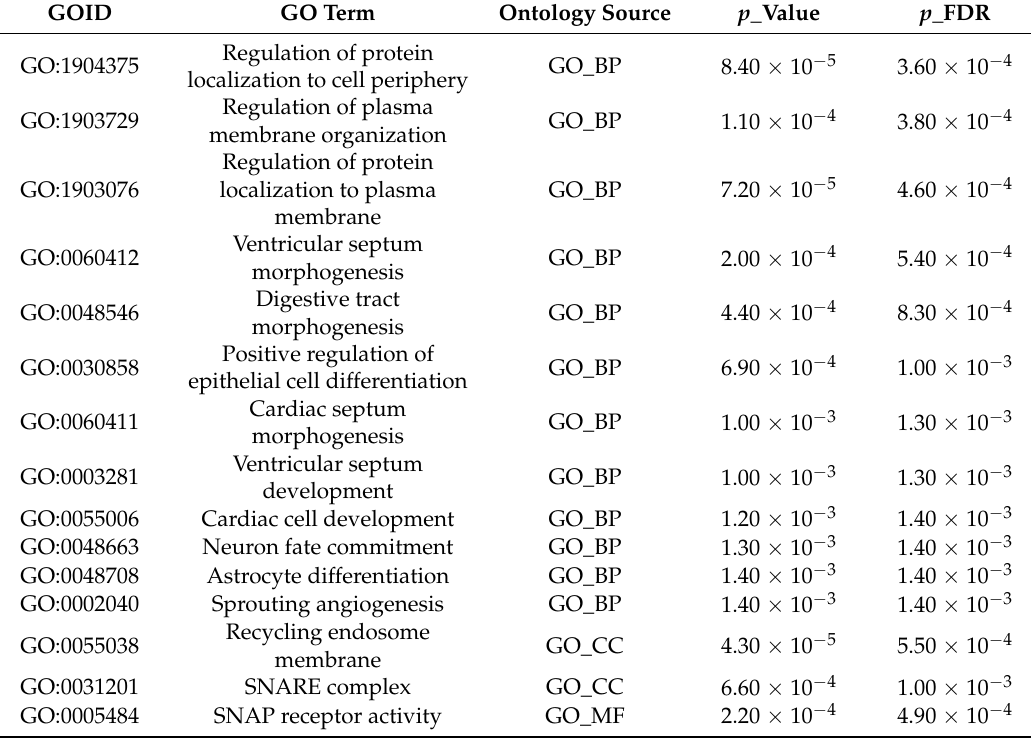
Table 1. Gene ontologies enriched for cis target genes of lncRNAs in LSO treatments. GOID GO Term Ontology